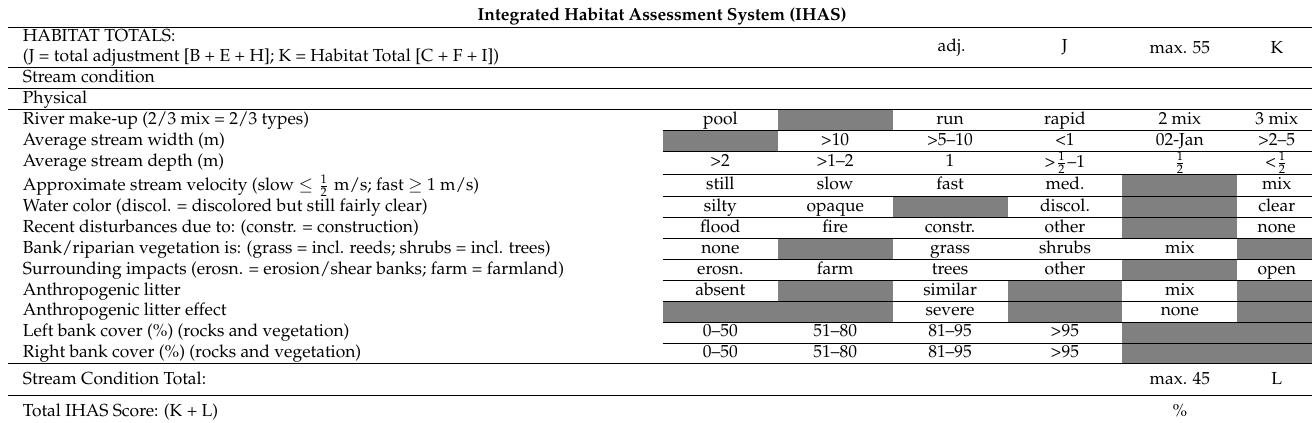
Table A1. Cont. Integrated Habitat Assessment System (IHAS) HABITAT TOTALS: adj.